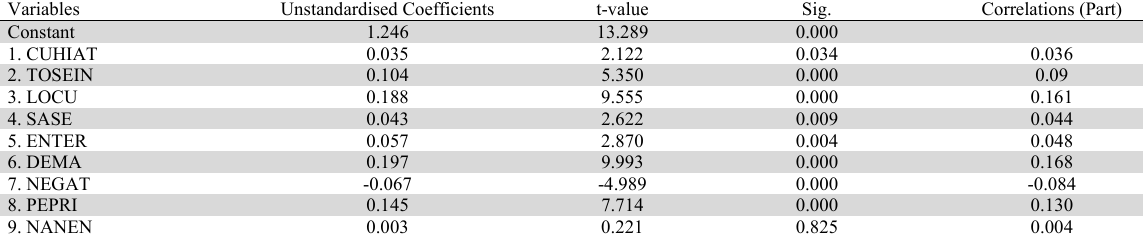
Effect Coefficients between Independent Variables and TODESA